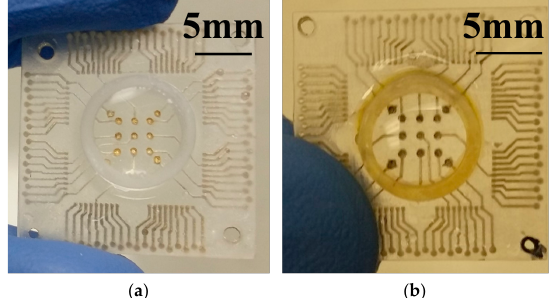
Figure 10. Optical micrographs of the MEA depicting the effect of electroless platinum plating on the ink casted silver electrodes for ( a ) Control sample with no plating and ( b ) 6 h of electroless deposition. A drop of isopropyl alcohol has been intentionally added to enhance the electrode image.